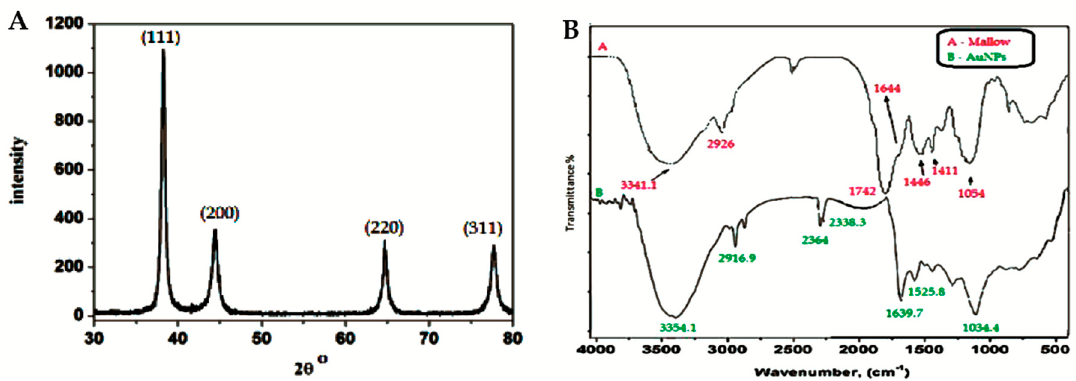
Figure 5. X-ray diffraction (XRD) pattern of Au NPs synthesized using C. olitorius (left) and Fourier- transform infrared (FTIR) spectra of ( A ) a plain mallow leaf and ( B ) capped Au NPs (right).